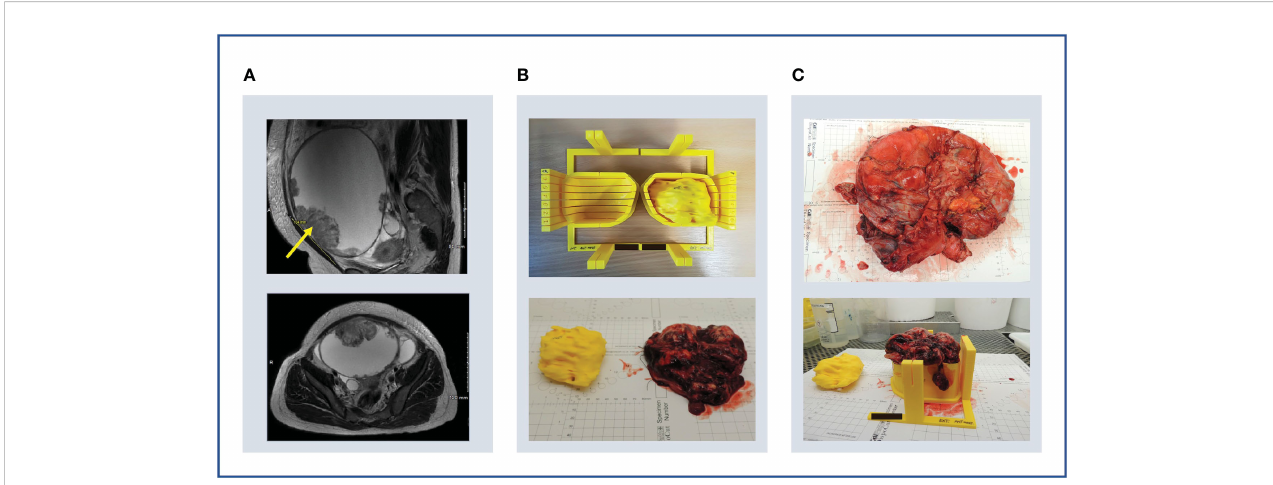
FIGURE 10 Case 4. (A) Upper panel: sagittal MRI image showing large cystic lesion with solid component in anterior wall (arrow). Lower panel: axial MRI image showing the same lesion (arrow) and positions of external (blue) and internal (green) mould bases. Note CT imaging was used for segmentation (MRI images used here for illustrative purposes only). (B) Upper panel: internal (left) and external (right) moulds with guides (circled) for orientation cut (dotted line). Lower panel: tumour replica and specimen with size discrepancy. (C) Upper panel: the ruptured cyst was removed en bloc – two orientation sutures (orange arrow, other suture on underside of specimen) and the resected cervix (blue arrow) were used for specimen orientation. Lower panel: ultimately, specimen size exceeded predicted mould dimensions due to an unusual interval of 53 days between imaging and surgery during which the tumour had increased in